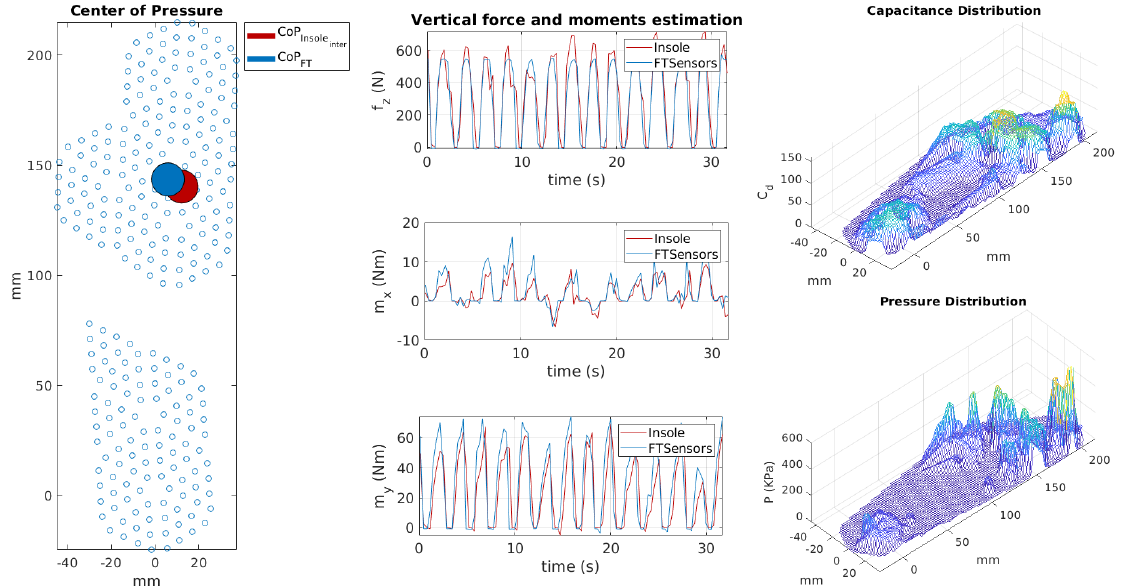
Figure 12. Online visualisation tool for the insoles. On the left-hand side, the comparison between centres of pressure estimated by force/torque (FT) sensors and insole. In the middle, estimation of vertical contact forces f z ( N ) and moments m x , m y ( Nm ) using the calibrated insole. On the right-hand side, the pressure